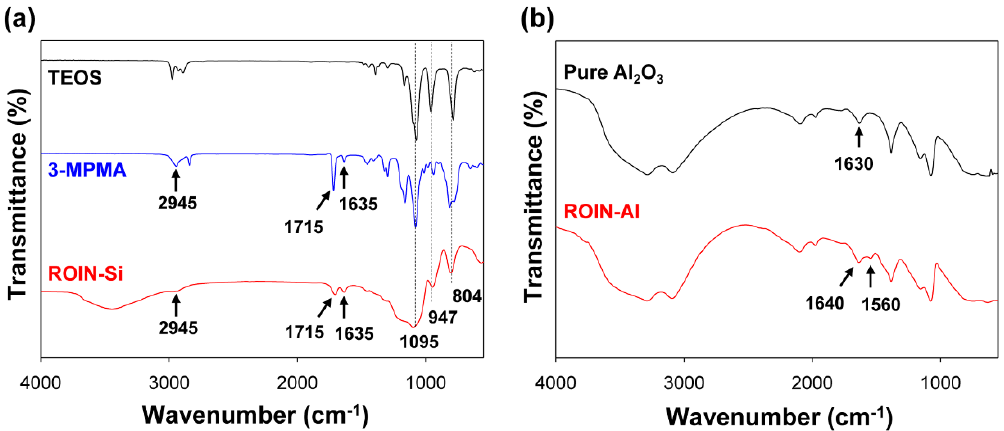
Figure 2. ( a ) FTIR spectra of tetraethyl orthosilicate (TEOS), 3-(trimethoxysilyl)propyl methacrylate (3-MPMA), and reactive hybrid silica nanoparticle. ( b ) FTIR spectra of pure aluminum oxide and reactive hybrid ROIN-Al nanoparticle.